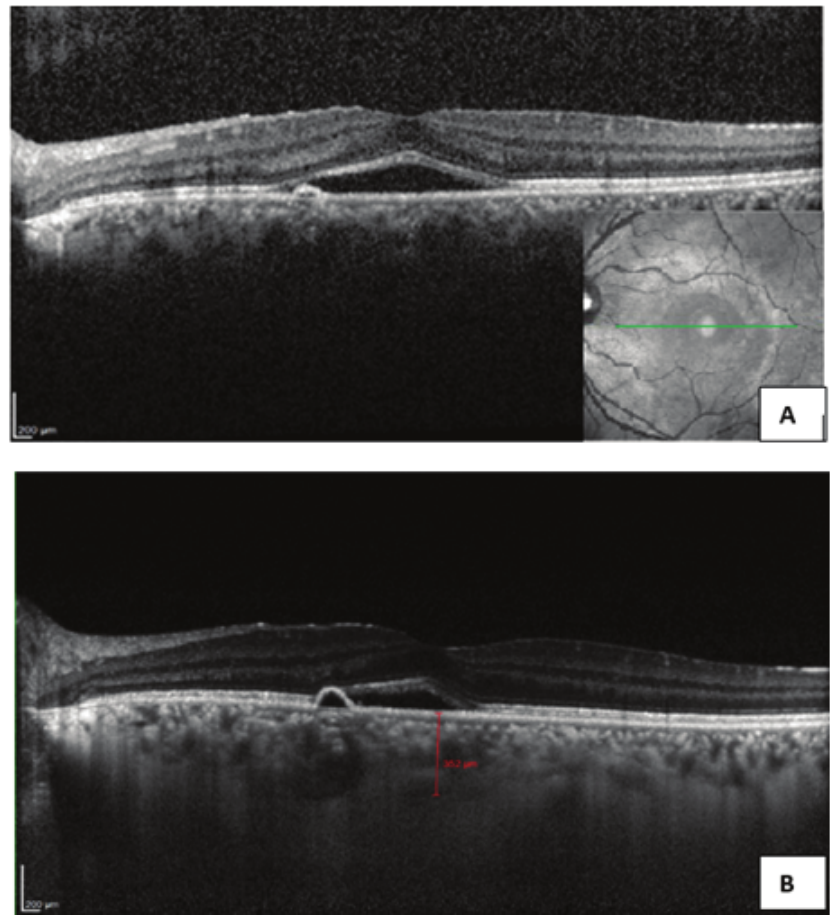
Figure 2. (A) SD-OCT of the left eye; neurosensory detachment with echo-free subretinal fluid adjacent to a well-defined PED. (B) EDI-OCT of the same eye; note the increased thickness of the choroid and congested